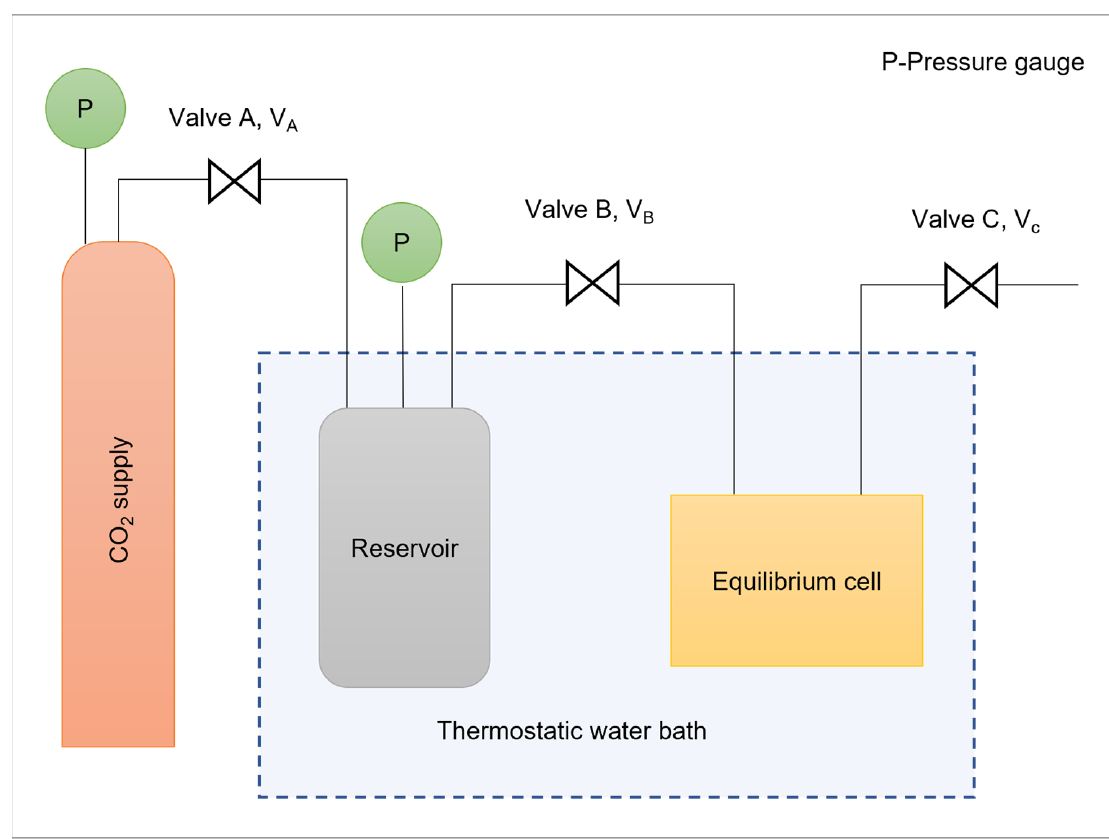
Figure 2. Schematic diagram of the isochoric saturation setup.